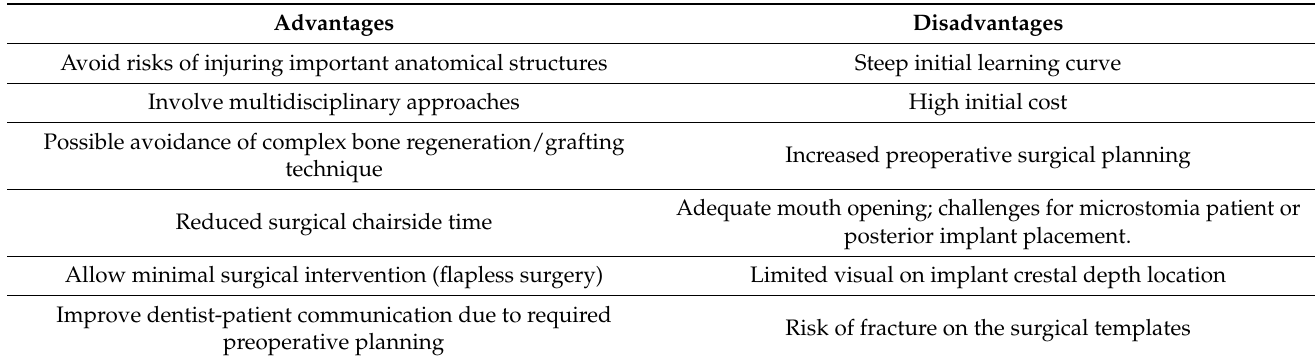
Table 2. List of advantages and disadvantages of implementing surgical static guided surgery.